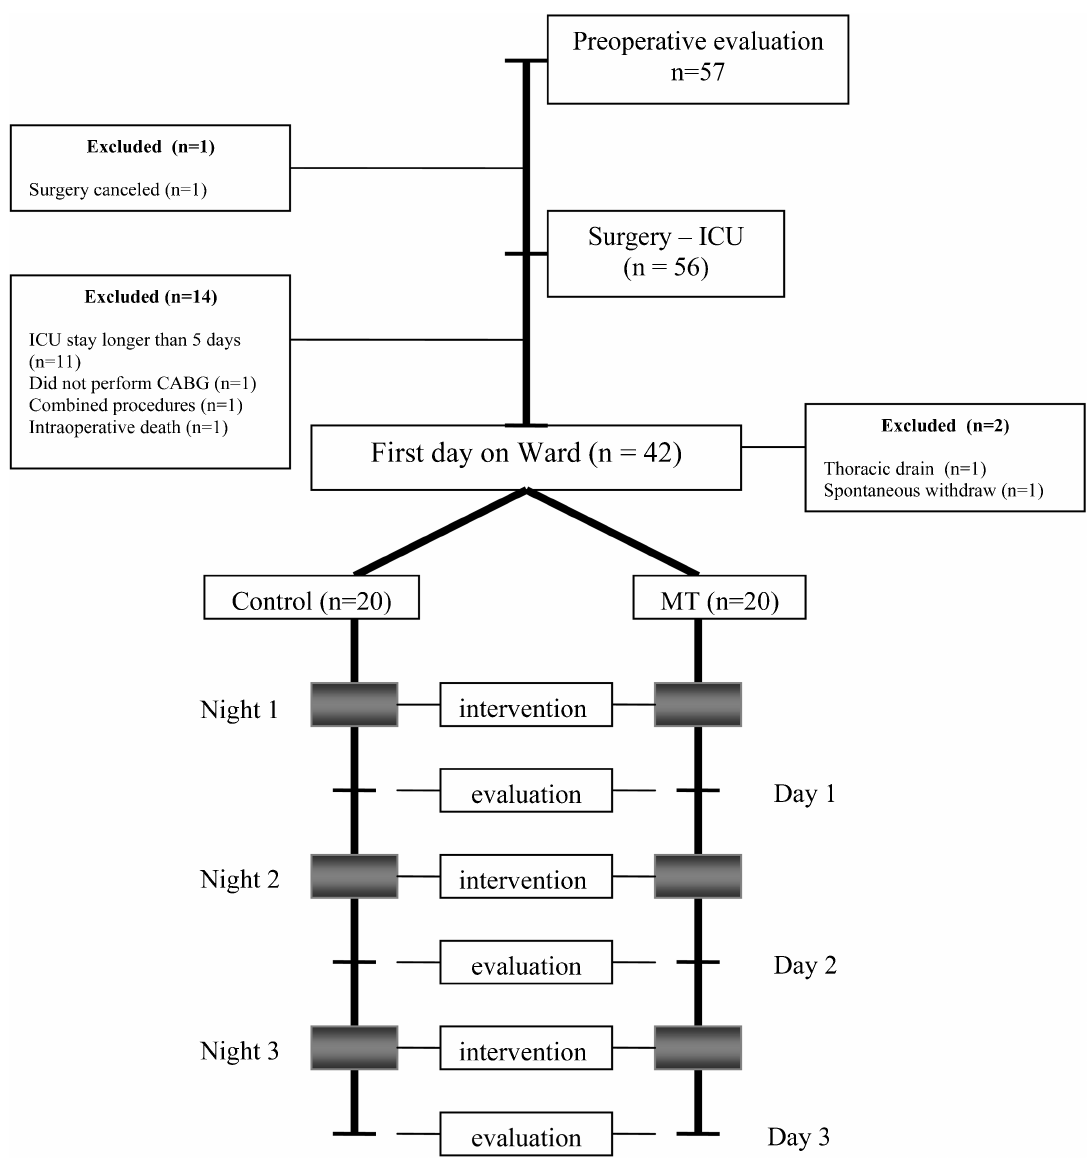
Figure 1 - Time course of